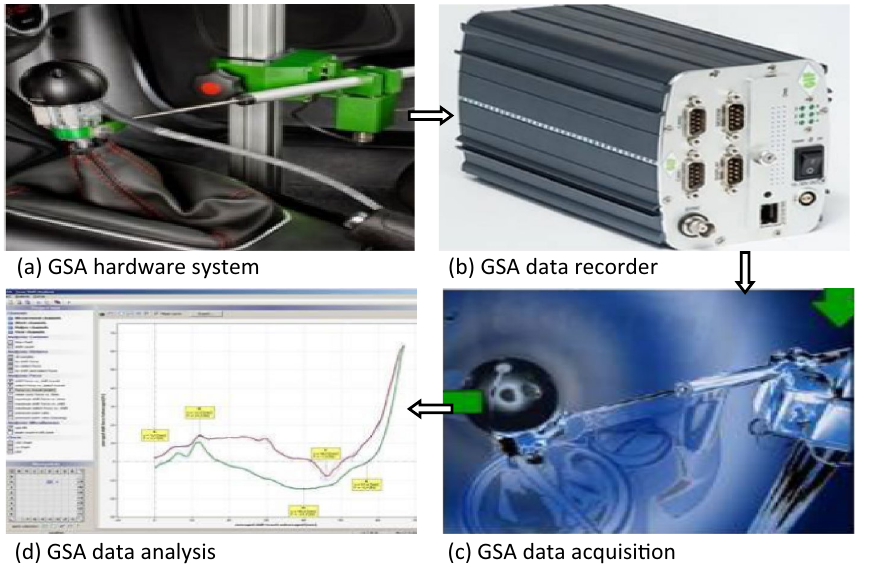
Figure 3. Shift testing and analysis